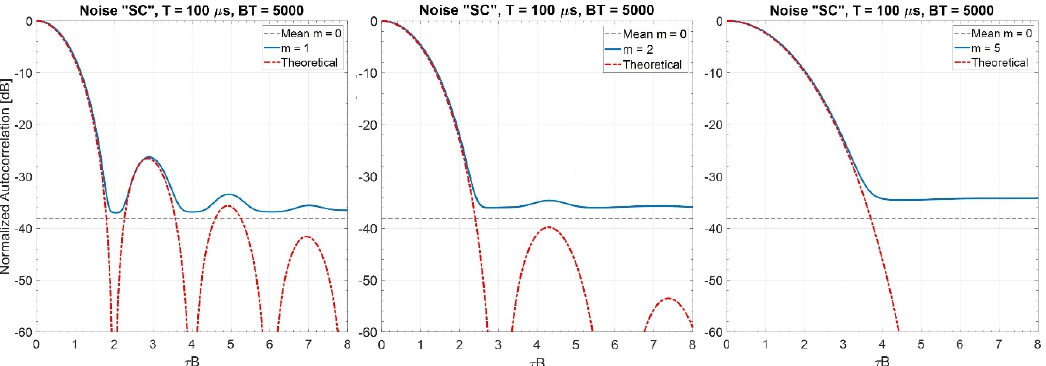
Figure 9. Normalized autocorrelation of “SC” noise waveforms, BT = 5000, m = 1, 2, and 5 (values are estimated on 1000 trials).